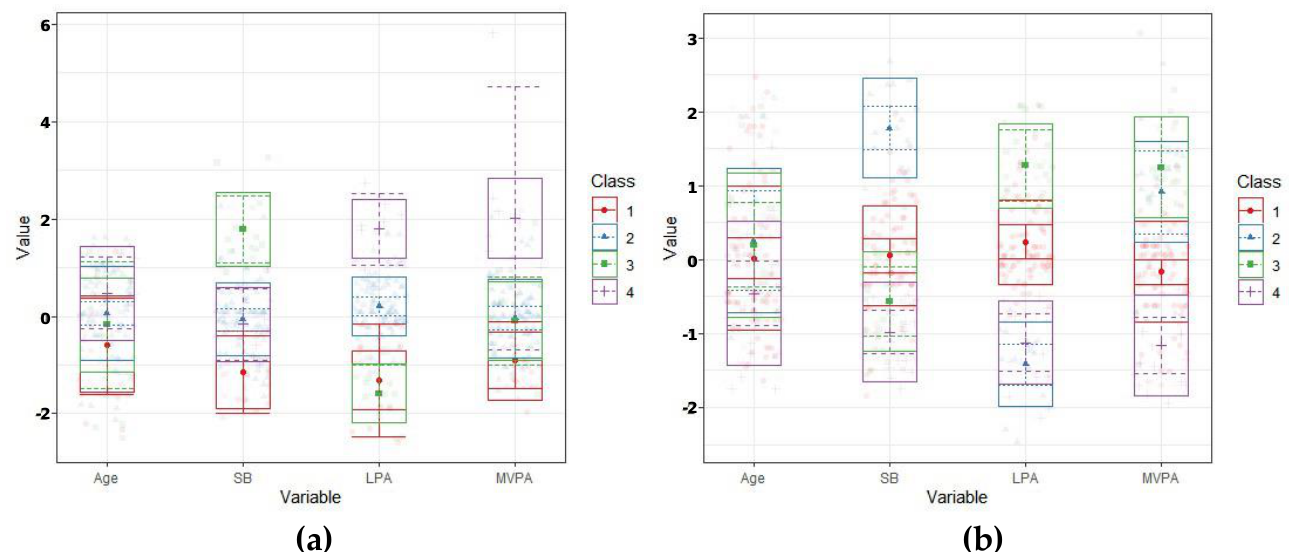
Figure 1. Z-score of movement behaviours clustered in four classes. ( a ) Clusters solutions of preschoolers C with sleep recommendations; ( b ) Clusters solutions of preschoolers NC with sleep rec- ommendations.